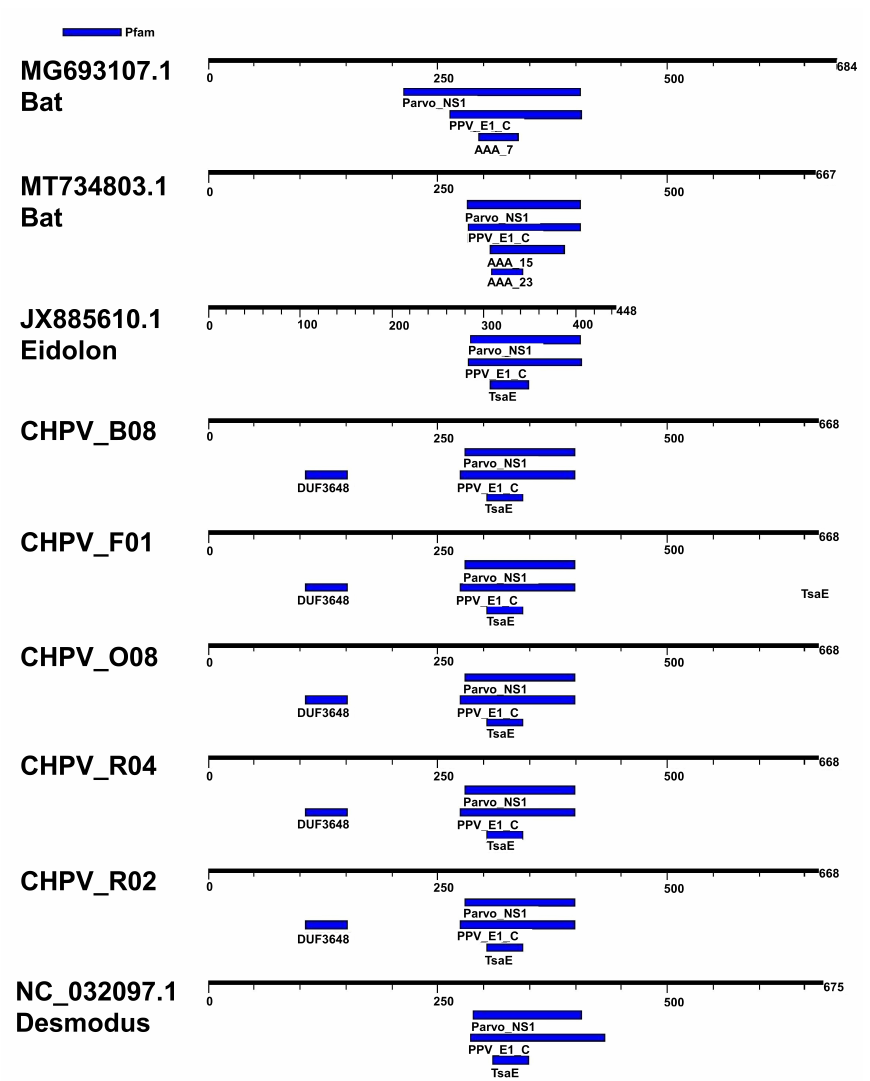
Figure 1. Motifs in the CHPV non-structural protein (NS1). Figure shows the motifs detected in the NS1 protein of CHPV. Motifs were detected using the server MotifFinder and the Pfam database was used as reference (https://www.genome.jp/tools/motif/, accessed on 22 January